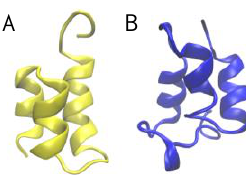
Figure 1. Ribbon presentations of the three-dimensional native structure of the E r -1 ( A ) and E n -1 ( B )